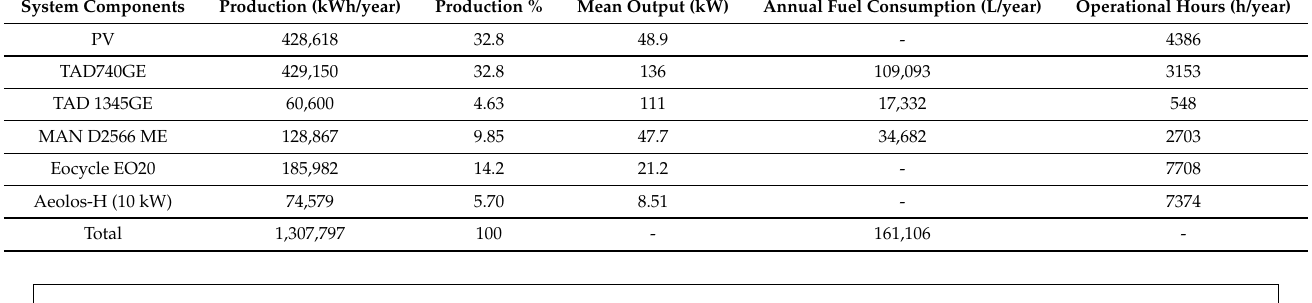
Table 15. Analytical electrical Production and technical characteristics for optimal configuration of Scenario 2. System Components